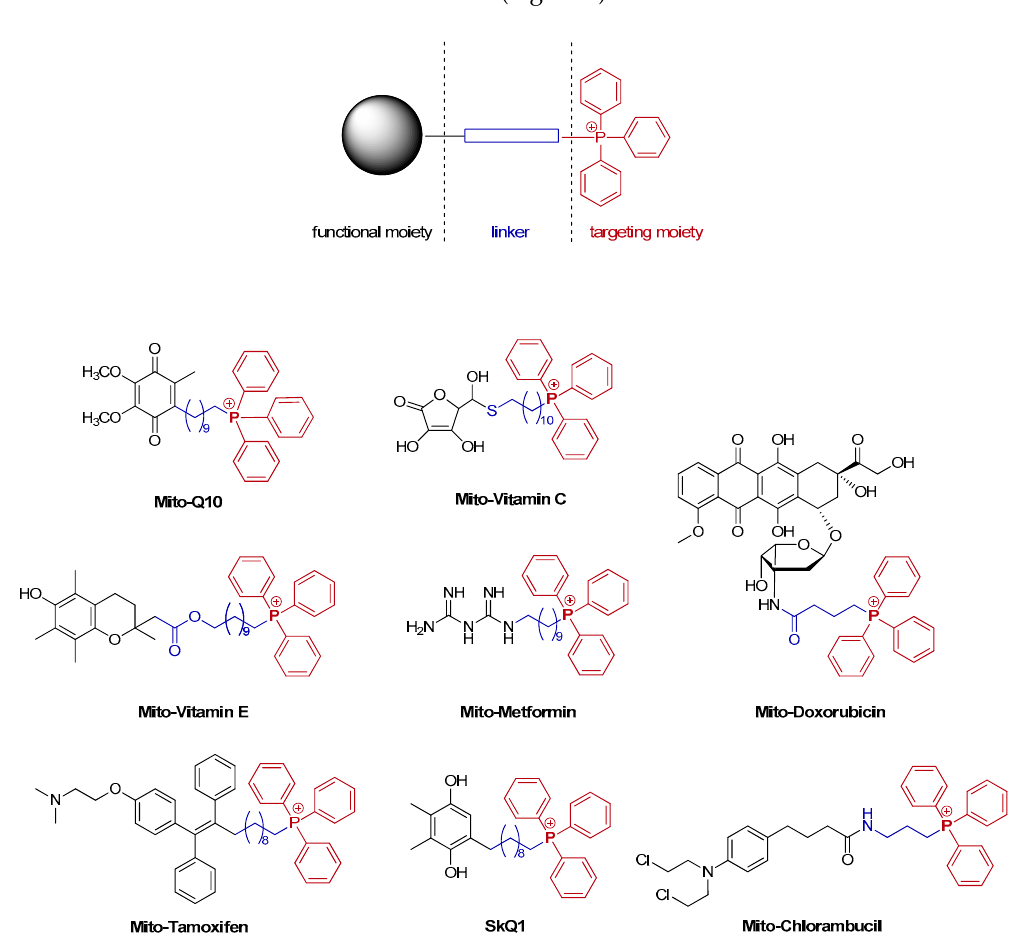
Figure 2. Examples of the TPP ⊕ -conjugated compounds